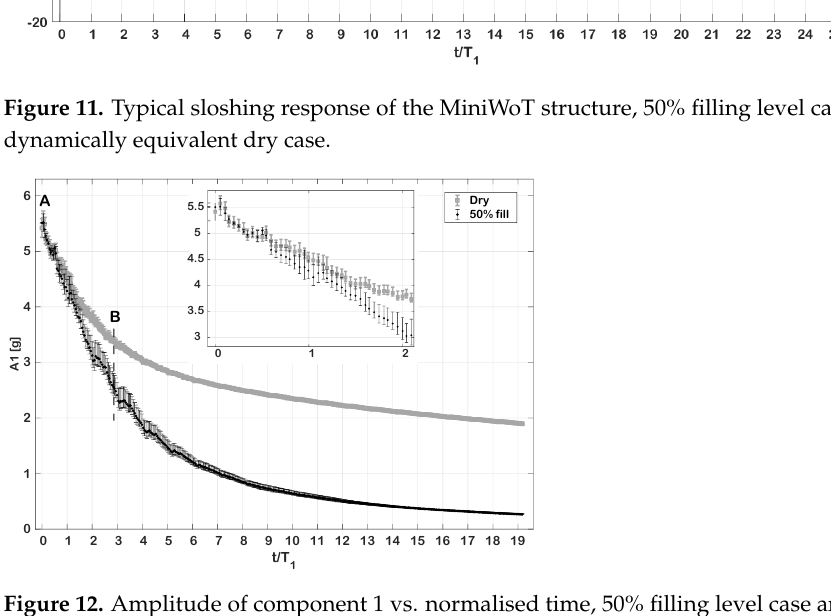
Figure 12. Amplitude of component 1 vs. normalised time, 50% filling level case and dynamically equivalent dry case. Error bars show the variability between test